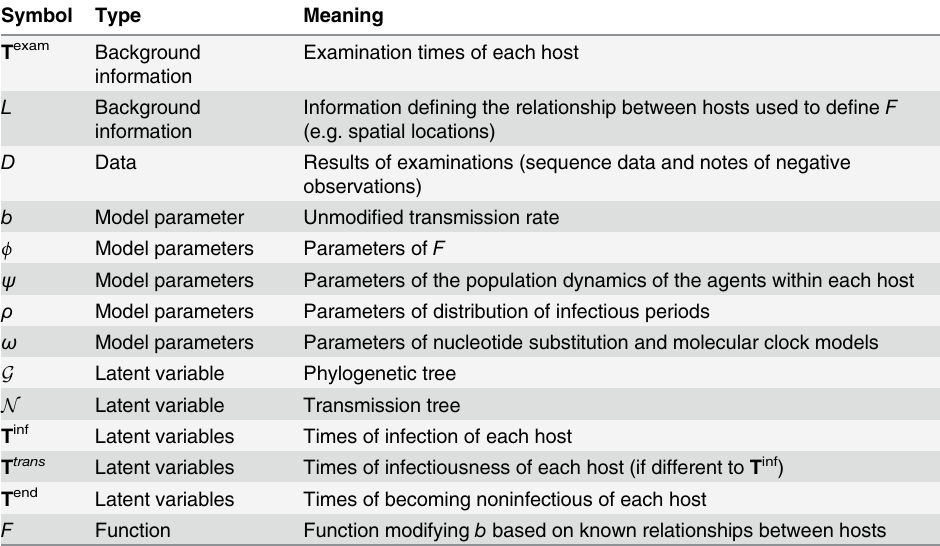
Table 1. Description of symbols used in the probability